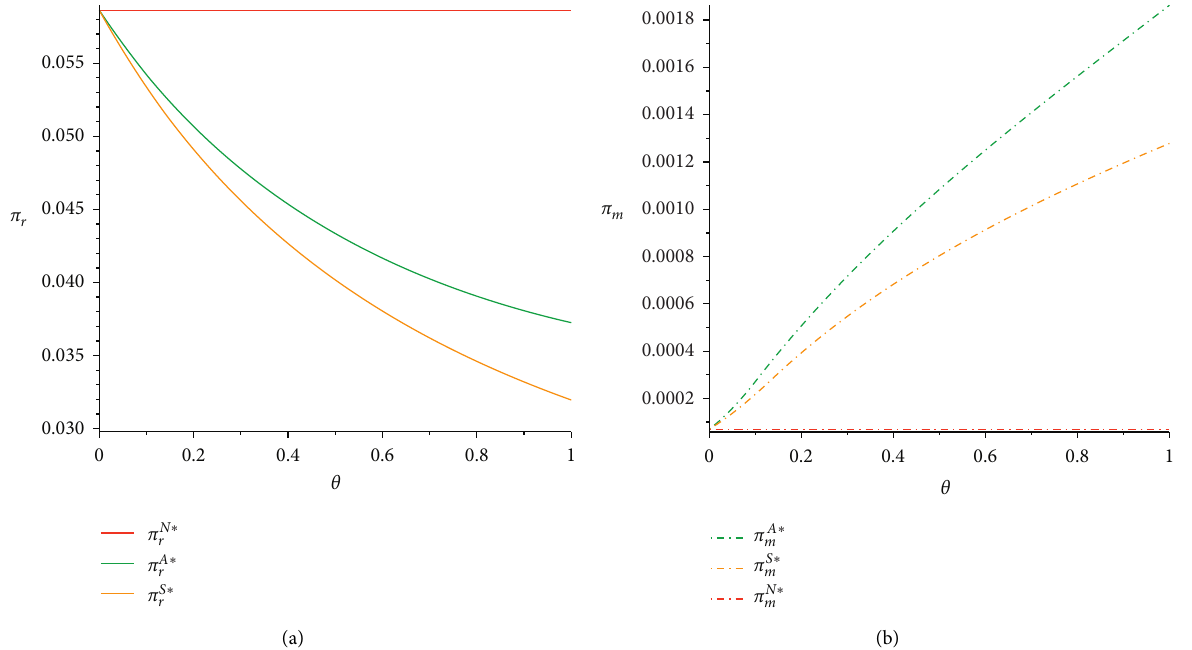
Figure 1: Comparison results of profits versus parameter θ when a � 0 . 25, b � 0 . 2, and c � 0 . 8. (a) Retailer’s equilibrium profits under three models. (b) Manufacture’s equilibrium profits under three models.